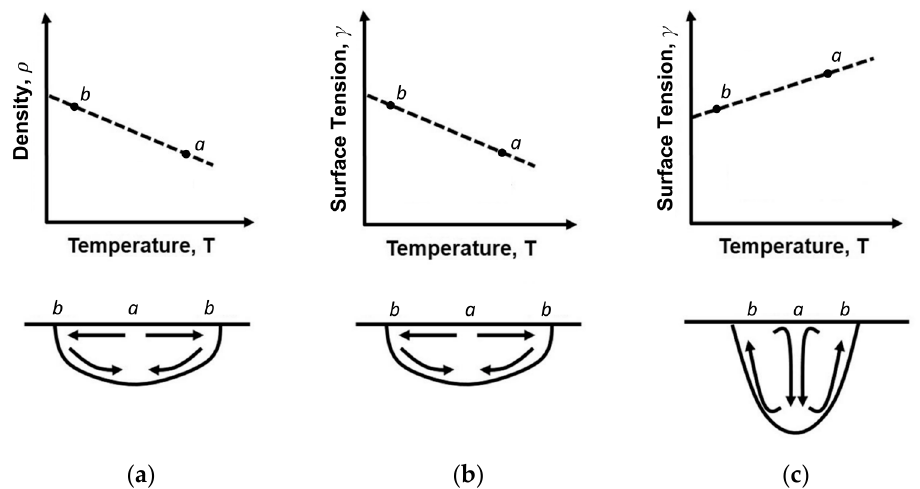
Figure 23. ( a ) Buoyancy forces and flows caused by the material density differences due to the temperature gradient (adapted from [114]). Marangoni flows caused by the surface tension gradients: ( b ) a negative value of surface tension temperature coefficient causes a wide and shallow melt pool morphology instead, ( c ) a positive value of surface tension temperature coefficient causes a deep and narrow melt pool morphology (adapted from [116]).